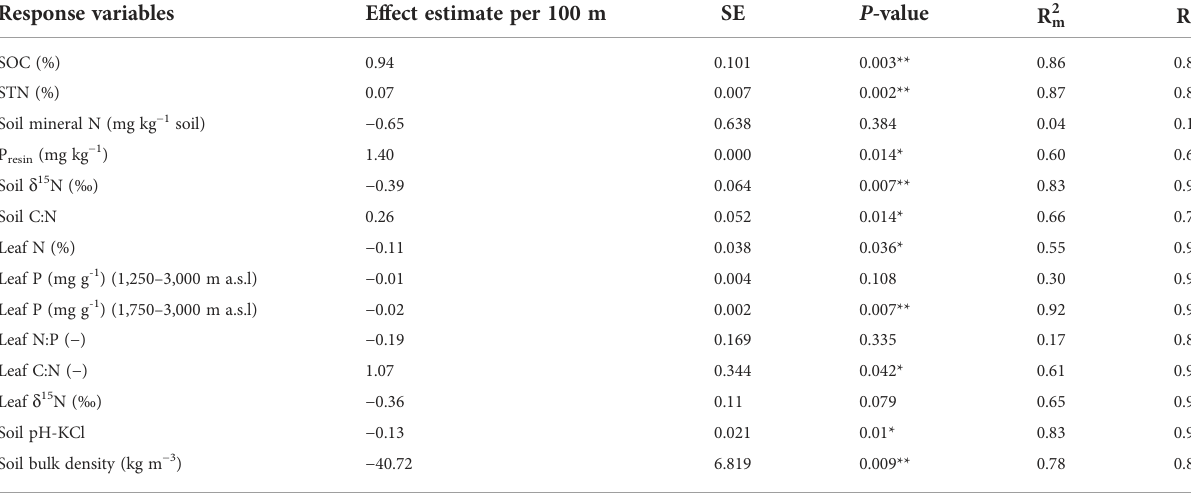
TABLE 2 Fixed effect estimates of elevation (per 100 m) for response variables; soil organic carbon (SOC), soil total nitrogen (STN), soil mineral N, soil bio-available P (P resin ), soil d 15 N, soil C:N, leaf N, leaf P, leaf N:P, leaf C:N, soil pH and soil bulk density (BD) with associated standard error (SE), P -value, marginal coef fi cient of determination (R 2 m ) , and conditional coef fi cient of determination (R 2 c )